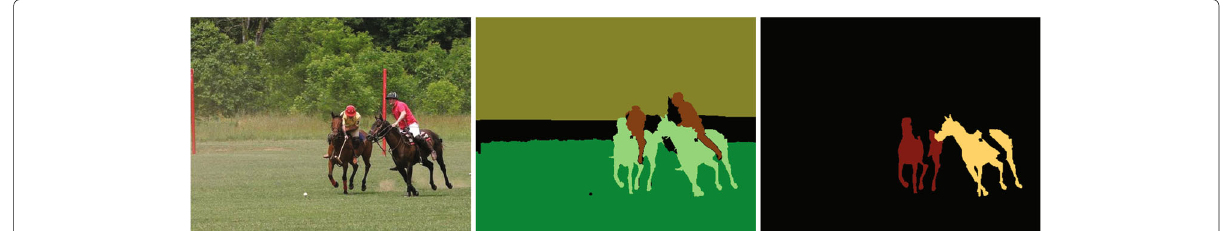
Fig. 1 Motivation. From left to right, the initial image, the motivation of scene-level labeling, and the motivation of object-level labeling. In the scene level, different colors indicate different categories. In the object level, different colors indicate different